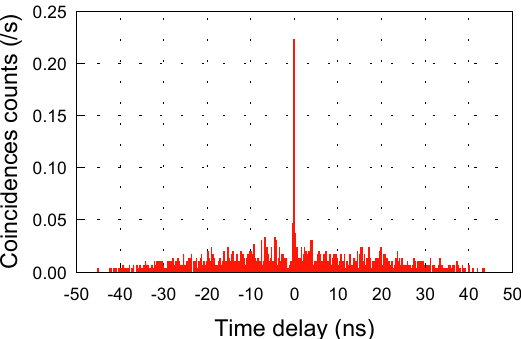
Figure 4. Time-correlation histogram of TE/TM photons around 1.57 µm at T = 15 °C. This sample is electrically injected with current pulses of 601 mA, a duration of 60 ns and a repetition rate of 40 kHz. The data were accumulated during 600 s with a sampling resolution of 162 ps.